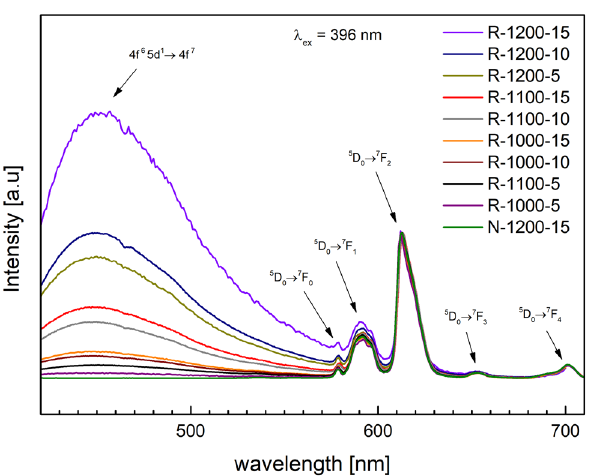
Figure 2. Photoluminescence spectra with transitions described in the figure. Samples were excited with 396 nm